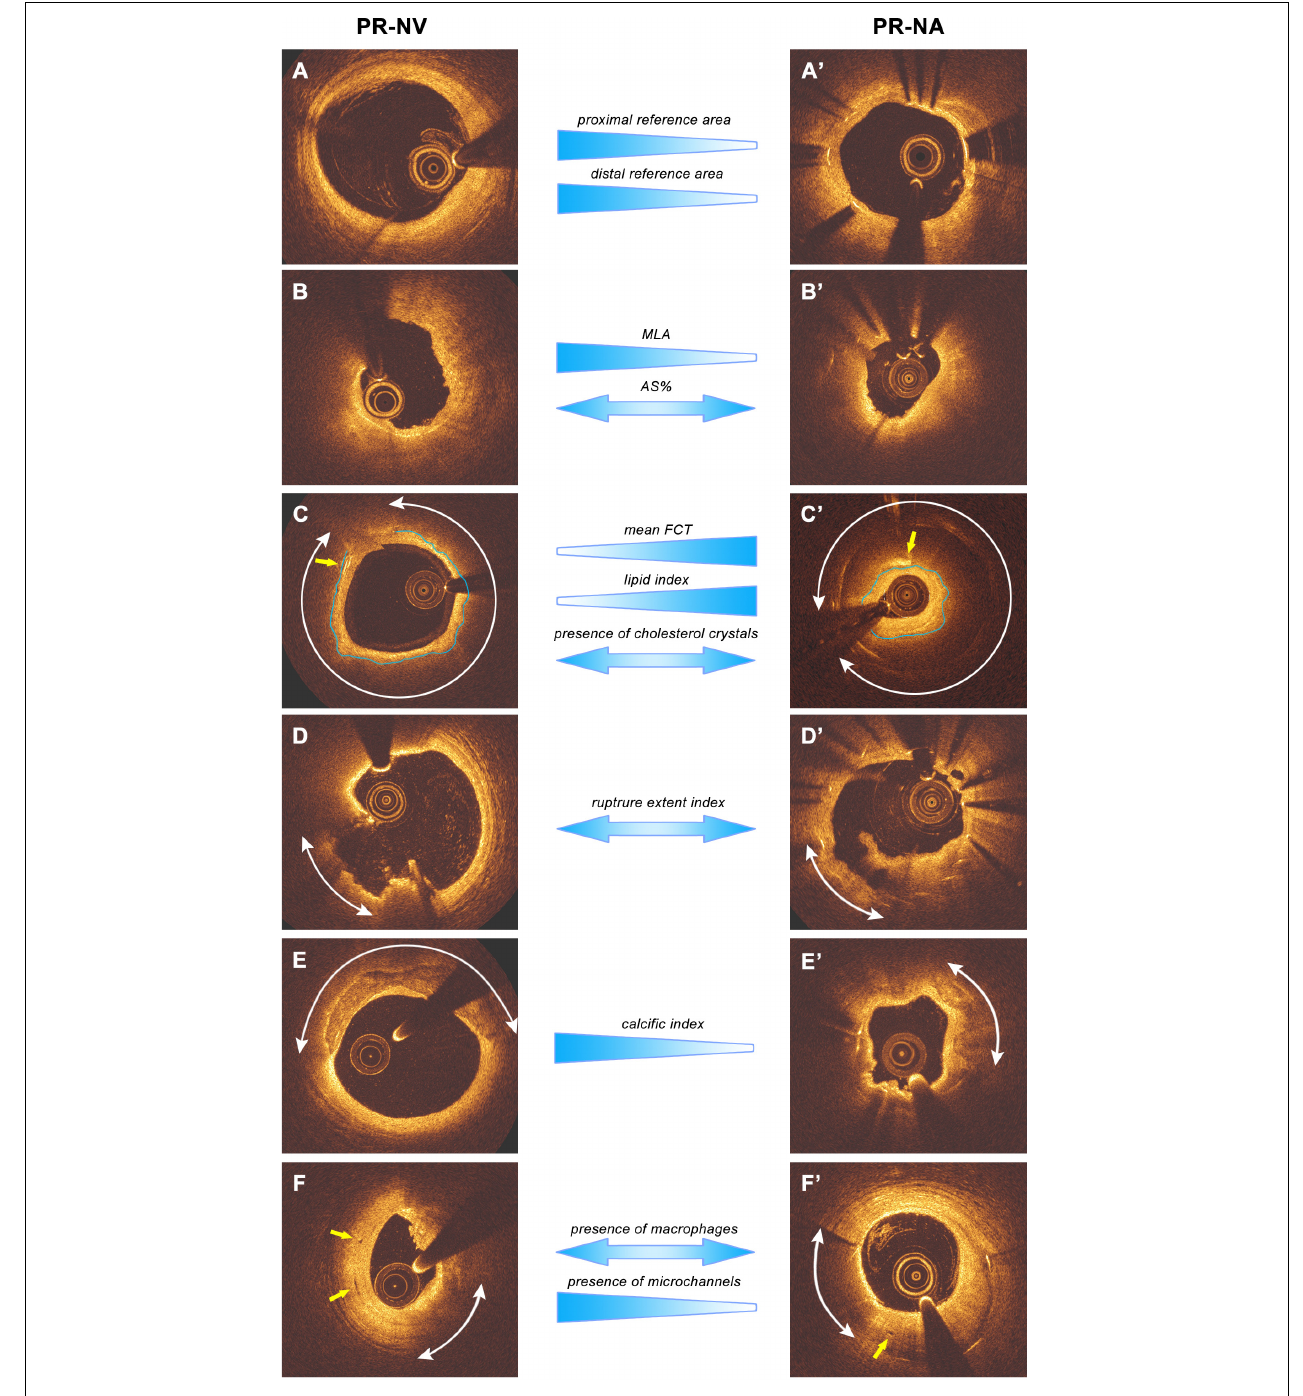
FIGURE 4 | Main results of lesion level-analysis and representative images. The images are presented as pairs from PR-NV and PR-NA groups. (A,A (cid:48) ) The reference segment, PR-NV group had larger proximal and distal reference area. (B,B (cid:48) ) The MLA site, PR-NV group reveals larger MLA than PR-NA group, while the two groups have similar AS%. (C,C (cid:48) ) Typical fibroatheroma and cholesterol crystals images, arcs indicate the lipid tissue while the yellow arrows are pointing at the cholesterol crystals. Blue lines draw the fibrous cap. PR-NV group reveals smaller mean FCT and lipid index, but similar incidence of cholesterol crystals compares to PR-NA group. (D,D (cid:48) ) Representative plaque rupture images, arcs indicate the ruptured cavity, PR-NV group reveals similar rupture extend index with PR-NA group. (E,E (cid:48) ) Typical calcification images. Arcs indicate the calcific tissue, PR-NV groups had bigger calcific index than PR-NA group. (F,F (cid:48) ) Macrophages and microchannels. Yellow arrows are pointing to the microchannels while arcs indicate the macrophages. PR-NV group has similar incidence of macrophages but more incidence of microchannels than PR-NA group.